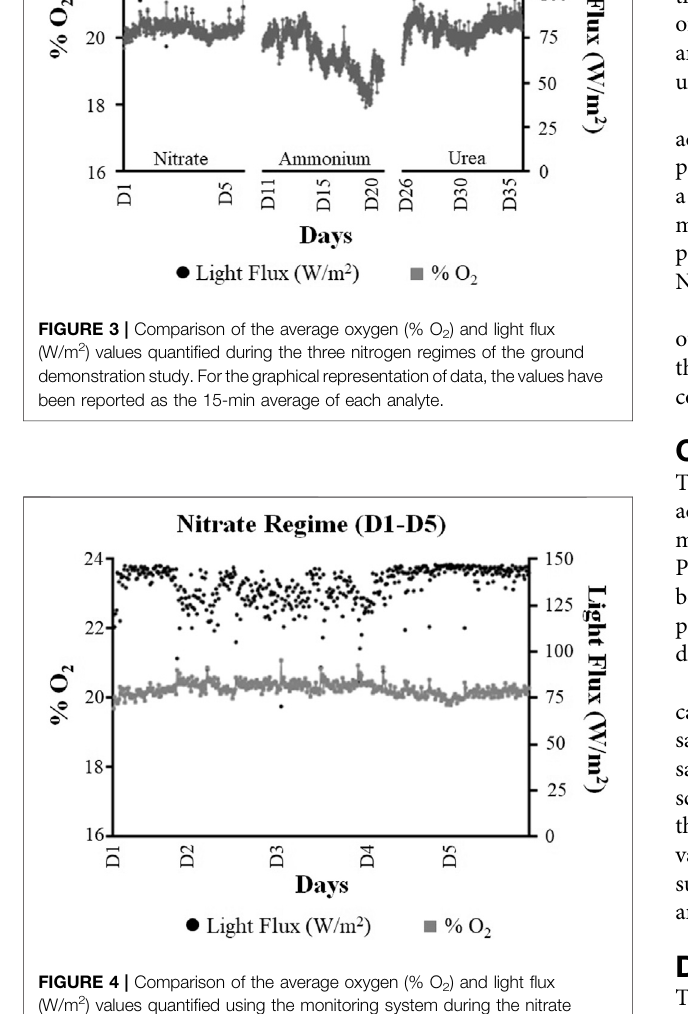
Frontiers in Astronomy and Space Sciences |